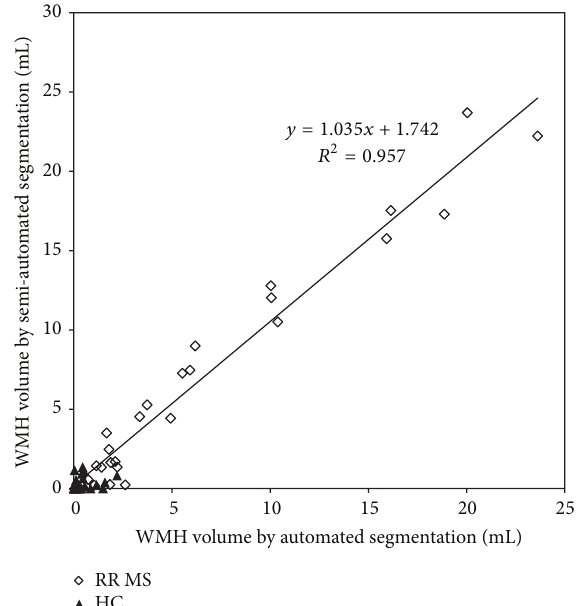
Figure 4: Correlation of the manual segmentation and automated segmentation methods. The open diamonds represent the MS patients and the solid triangles represent normal controls.